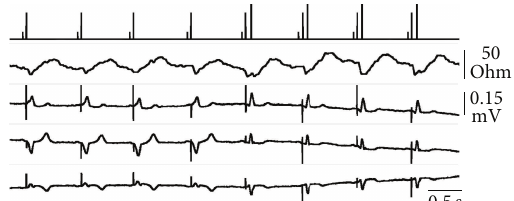
Figure 2: Real-time telemetry of event markers (1st tracing) and transvalvalvular impedance (2nd tracing) with simultaneous surface ECG recording (I, III, and aVR from the 3rd to bottom tracings, all with the same voltage scale) during ventricular threshold analysis in VVI. On the markers tracing, long bars represent ventricular pacing and short bars atrial sensing. The 6th spike energy was below the threshold. The capture failure was recognized by the TVI system and the pacemaker promptly increased the pulse amplitude, restoring effective ventricular stimulation.